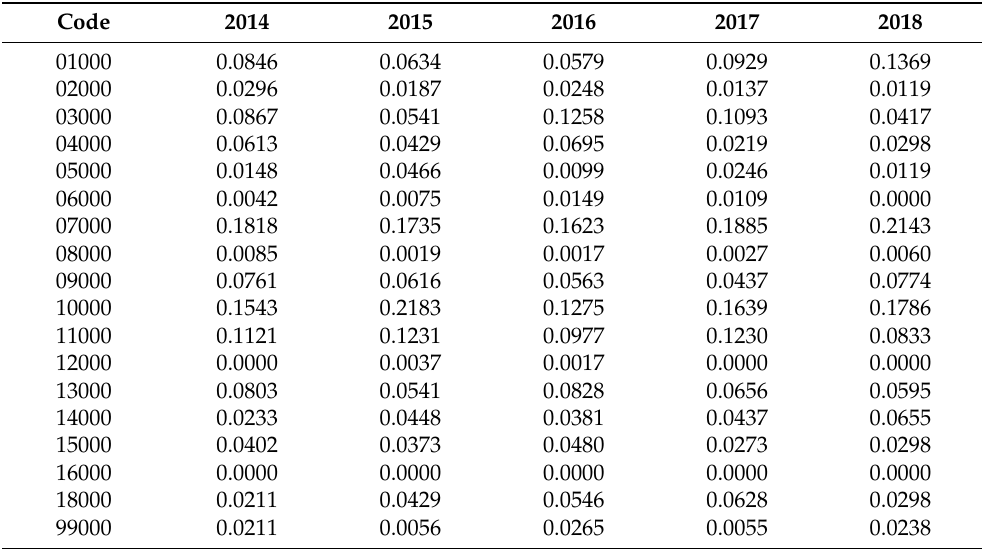
Table A5. The first step of fuzzification of Taiwanese ships deficiency data in Tokyo MoU.